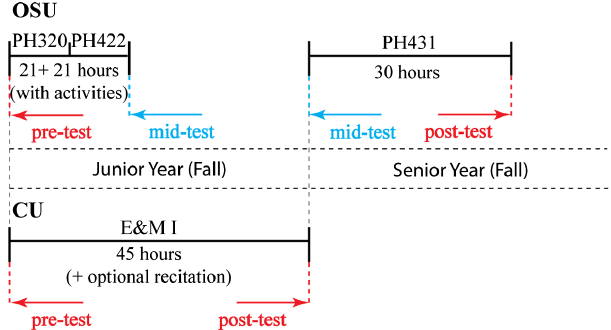
FIG. 1. Schedule of administering the CUE at OSU (quarter systems) and CU (semester system). The horizontal axis repre- sents weeks. The CU Electricity and Magnetism I course occurs over 15 weeks, whereas the PH320 and PH422 Paradigms are more intense and last 3 weeks